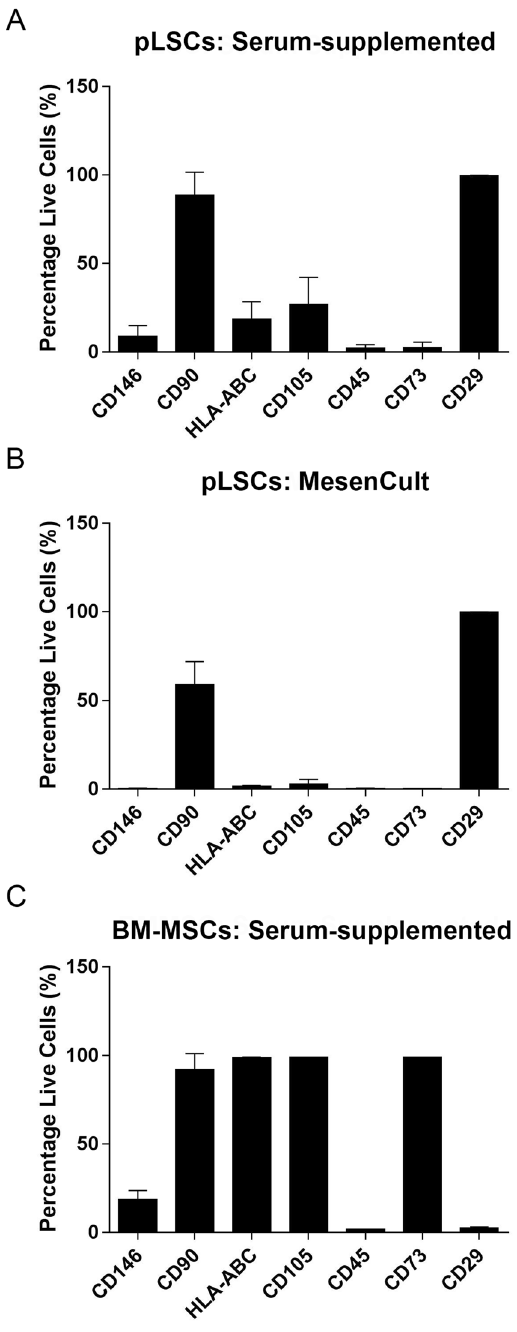
Figure 2. Phenotyping of pLSCs by flow cytometry. PLSCs grown in medium containing 10% FBS ( A ) or in serum-free MesenCult TM -XF medium ( B ). HBM-MSCs were included as a control ( C ). Data is shown as mean ± standard deviation. Values were pooled from three biological replicates performed in technical